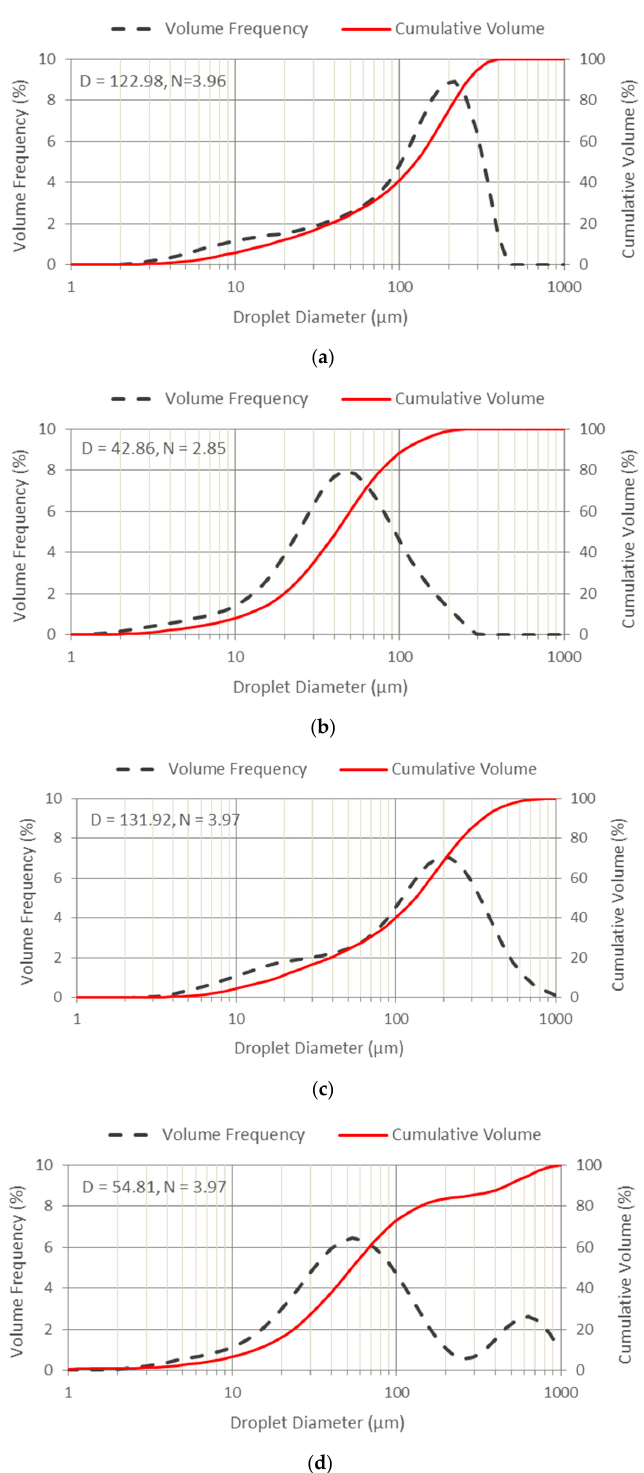
Figure 3. Distribution spectra of the droplet diameters obtained for: ( a ) ZBCN1 and a pressure of 1 bar, ( b ) ZBCN1 and a pressure of 3 bar, ( c ) ZBCN4 and a pressure of 1 bar, ( d ) ZBCN4 and a pressure of 3 bar. The red solid curve indicates the cumulative volume percentage per droplet size; the black dashed curve refers to the volume percentage per droplet size (volume frequency); and D and N are the parameters that describe the fitting of the obtained results to the log-normal size distribution.